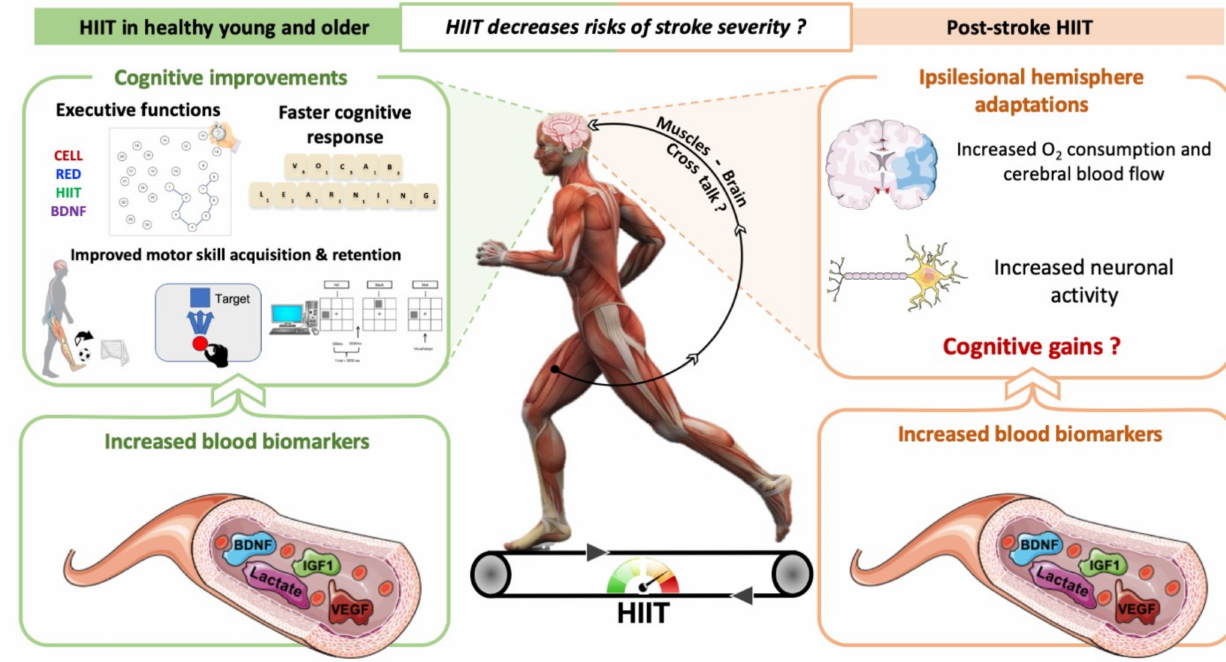
Figure 1. Overview of the influence of high-intensity interval training (HIIT) on neuroplasticity and learning/memory performance in healthy humans and individuals with stroke. HIIT enhances circulating biomarker expression of neuro- plasticity processes in individuals with stroke. The HIIT effects on cognitive functions remain to be defined despite some authors finding benefits in cognitive performance in healthy